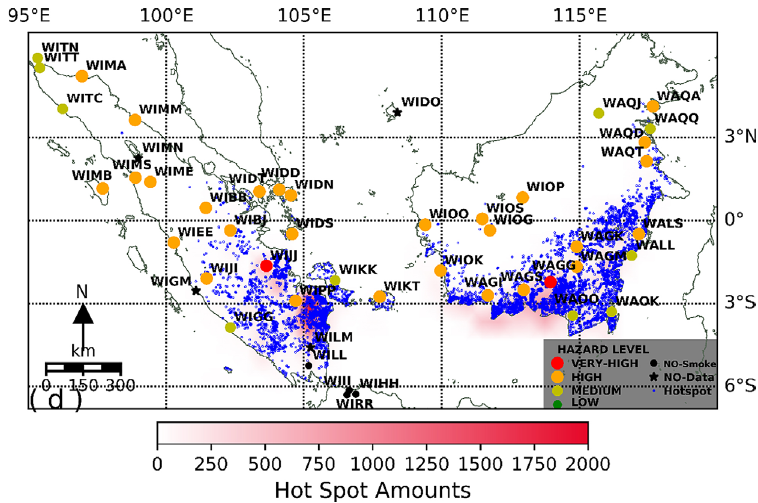
Fig. 4 d. The same as Fig. 4 a, for Month October 2015.